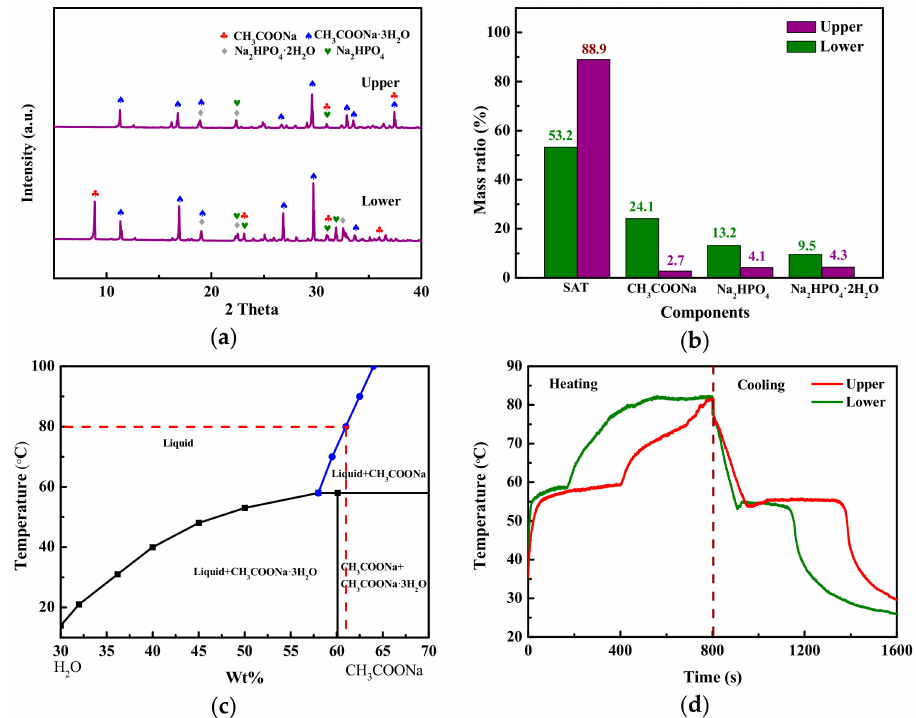
Figure 5. ( a ) XRD patterns and ( b ) semi-quantitative analyses of upper and lower samples of SAT / 5 wt.% DSP; ( c ) Phase diagram of sodium acetate-water system [13]; ( d ) Temperature–time curves of upper and lower samples of SAT / 5 wt.%